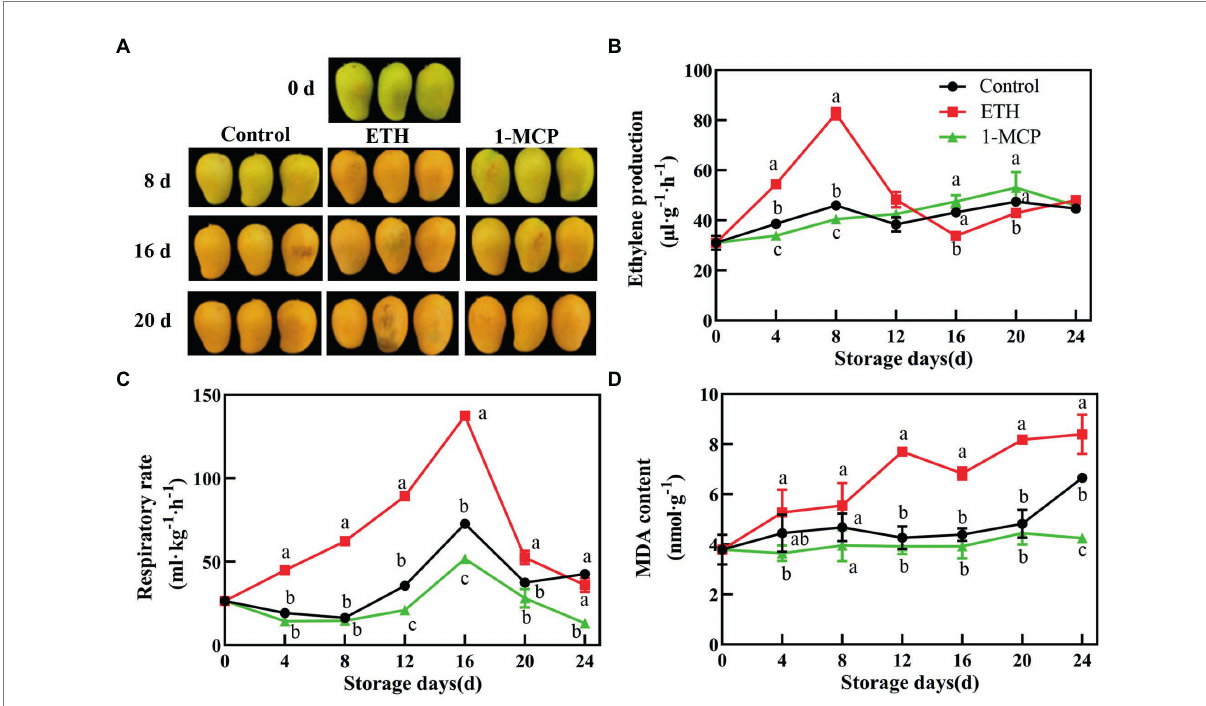
FIGURE 1 Effects of different treatments on ripening phenotype (A) , ethylene production (B) , respiratory rate (C) and MDA content (D) in mango fruit during storage at 15 ° C. The data are presented as means ± standard deviations. Means with different letters are significantly different at p < 0.05.